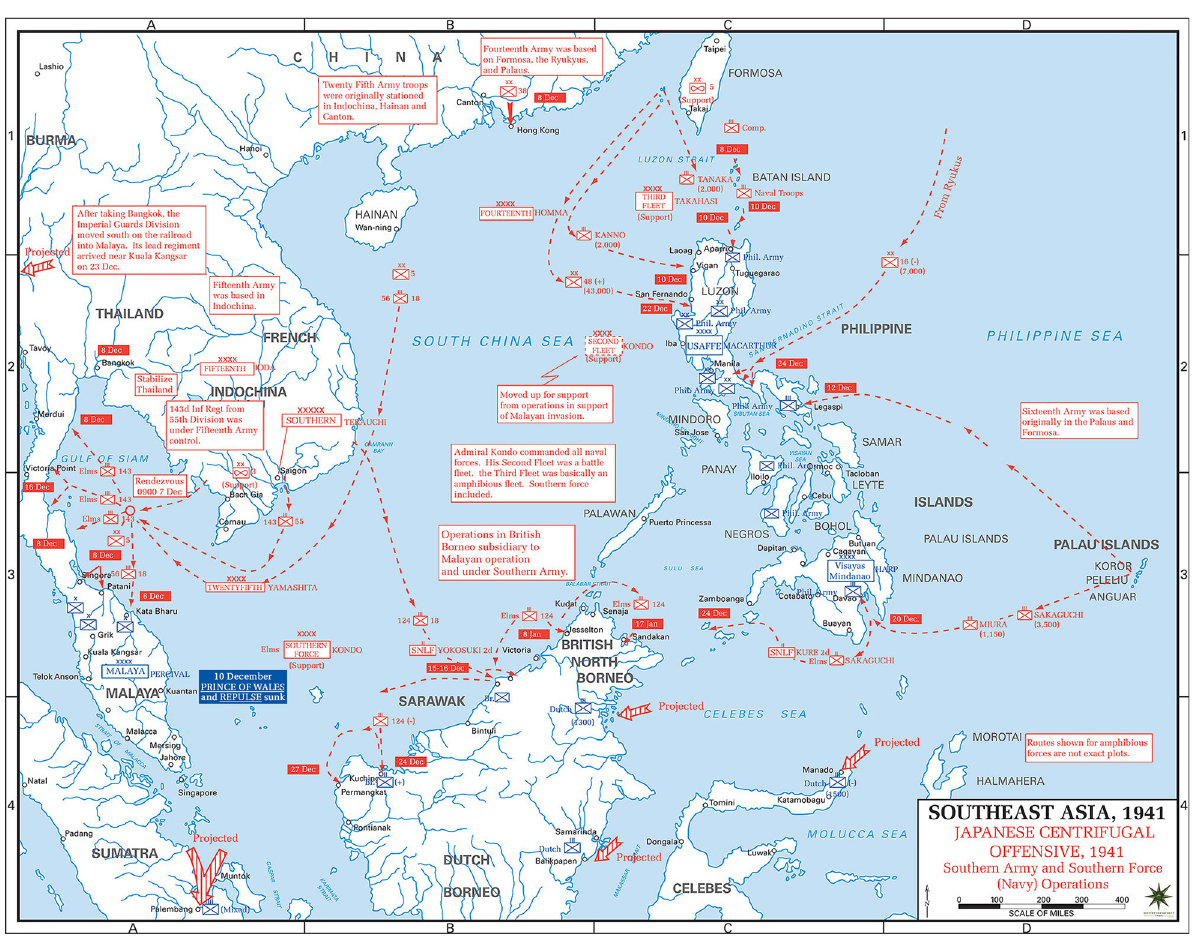
Fig. 1 Map of Japanese offensive in Southeast Asia in 1941. After attacking the Pacific Fleet at Pearl Harbor, the Japanese invaded Hong Kong and Malaysia on 8 December 1941 (Source: public domain image, courtesy of the United States Military Academy Department of History, available at